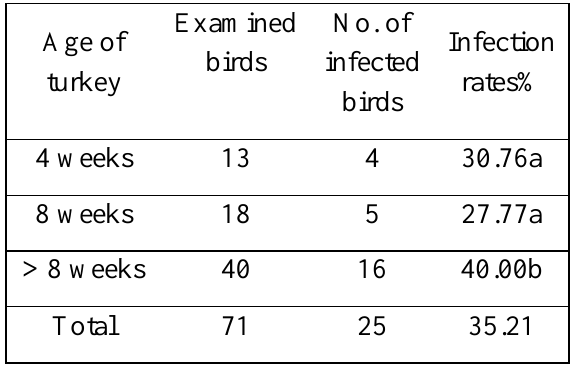
Fig. 2: a. Larva of Strongyloides avium 10X , b. The anterior end of the larva is 40X, and Regarding the age, the lowest and the highest infection rates were noticed in the eight weeks (27.77%) and more than eight weeks (40%), respectively, which were significantly different at a level of (P <0.05). The results revealed that the total percentage of infection with nematode helminths and Eimeria was 35.21%, shown in table (2). Table 2: The infection rates and numbers of nematodes and Eimeria spp . in turkeys and its relationship with animal age: